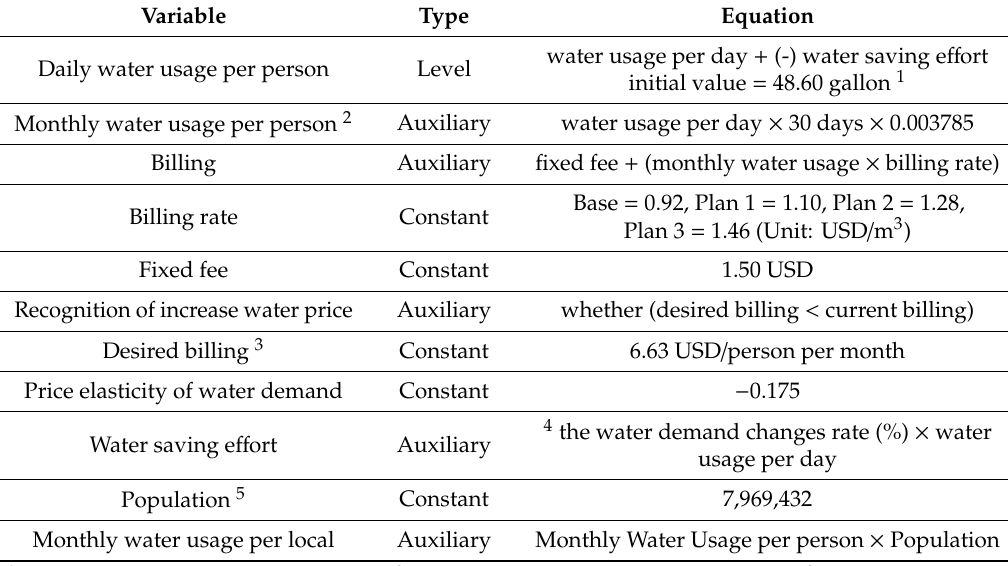
Table 2. Variables of the SD model for policy